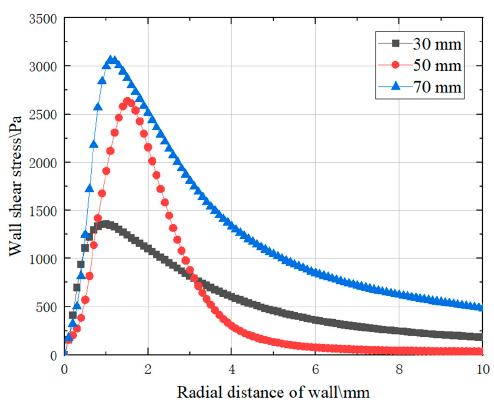
Figure 8. Wall shear stress distributions under different standoff distances.